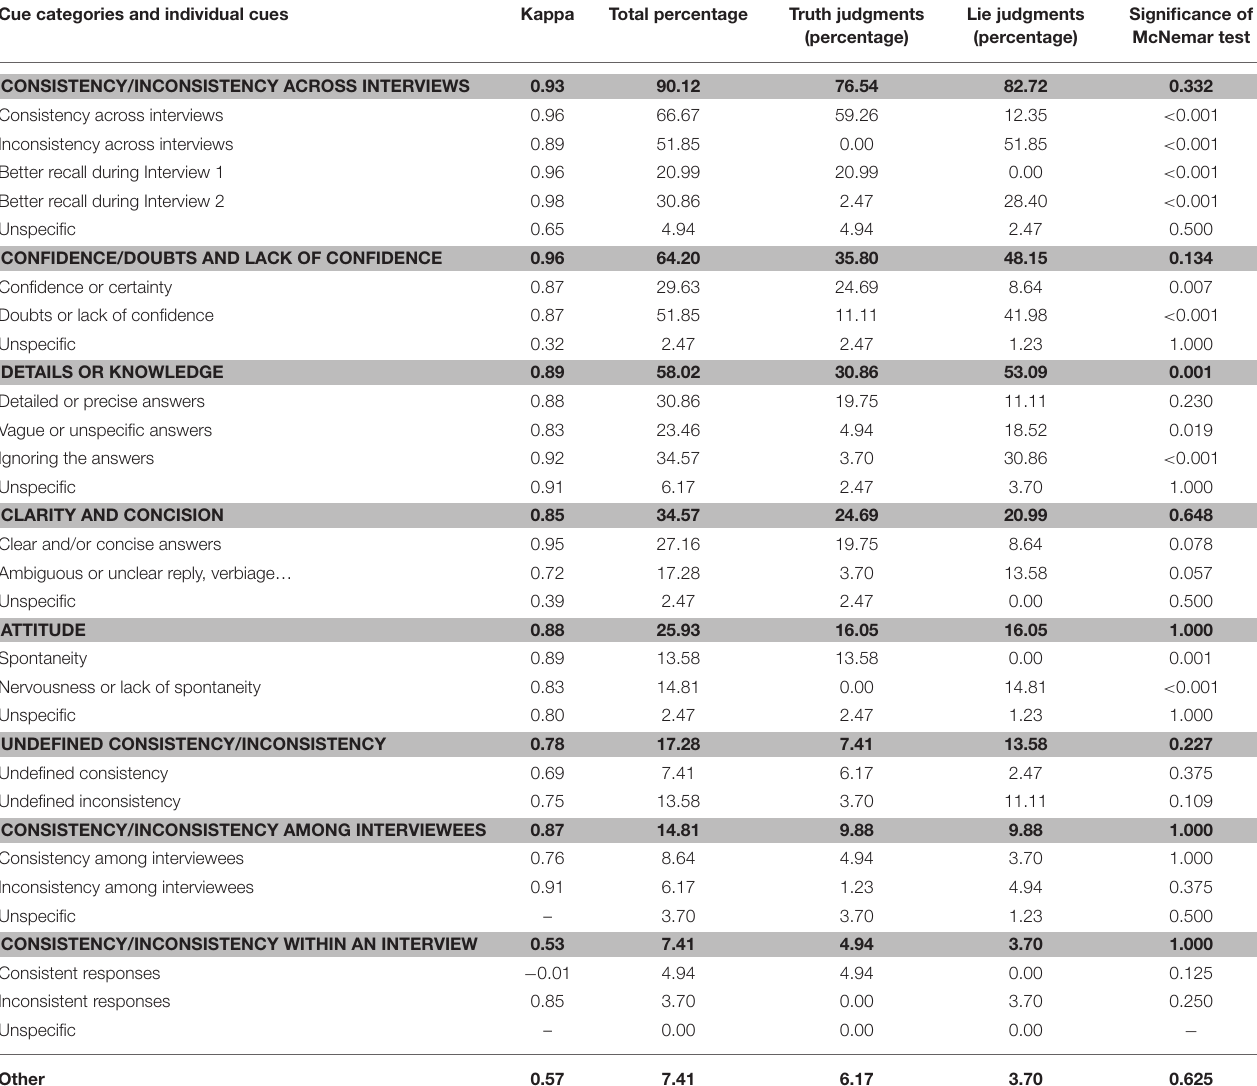
TABLE 2 | Reasons provided by the uninstructed participants in Experiment 1 to explain their truth and lie judgments. Cue categories and individual